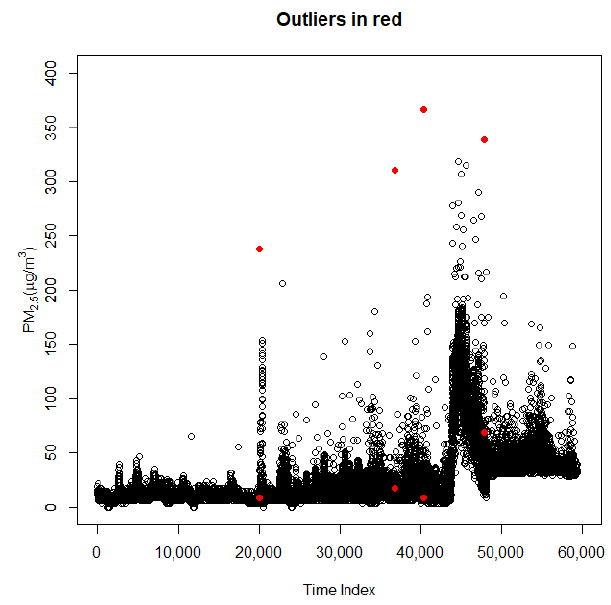
Figure 5. Anomalies are shown in red.